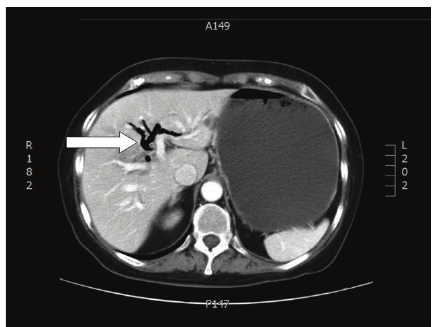
Figure 4: Aerobilia (personal observation).